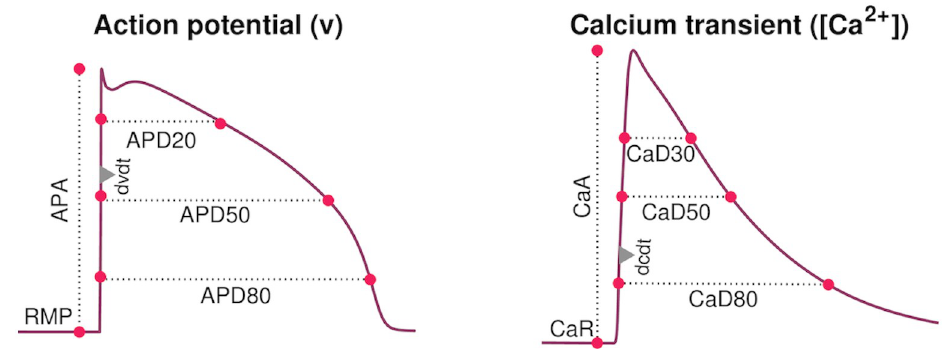
Fig 1. Illustration of the AP and Ca 2+ transient biomarkers utilized in the cost function employed to identify optimal drug concentrations. From the AP, we consider the resting membrane potential (RMP), the AP amplitude (APA), the maximal upstroke velocity (dvdt) and the AP duration at different percentages of repolarization (APD10, APD50, ... , APD90). From the cytosolic Ca 2+ transient, we consider the resting Ca 2+ concentration (CaR), the Ca 2+ transient amplitude (CaA), the maximal upstroke velocity (dcdt) and the calcium transient durations CaD30, CaD50, and